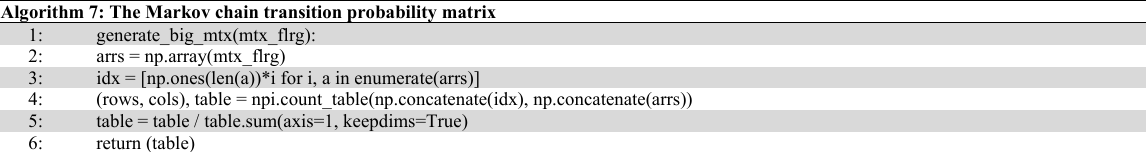
Algorithm 7: The Markov chain transition probability matrix 1: